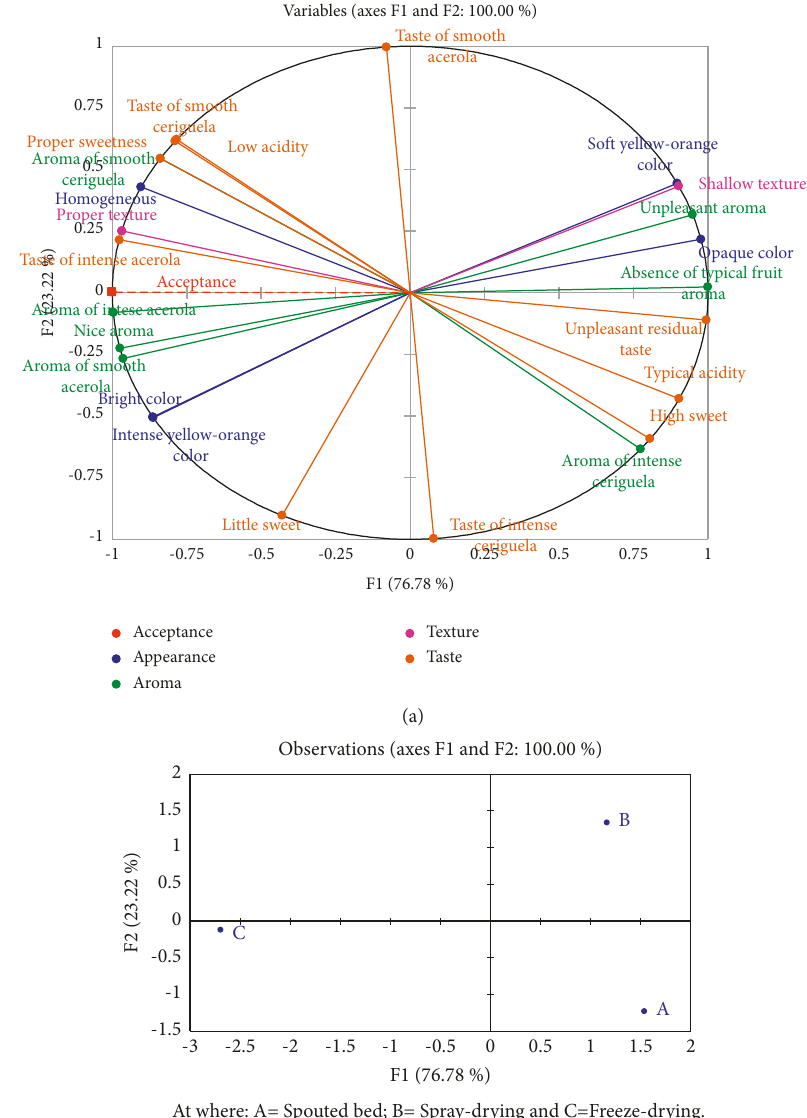
Figure 1: Multiple factorial analysis (MFA) of CATA data. (a) Representation of the terms used to describe the three mixed juice prepared with ACMP obtained by the different drying methods (spouted bed drying, spray-drying, and freeze-drying) and their acceptance and (b) representation of mixed juice obtained by